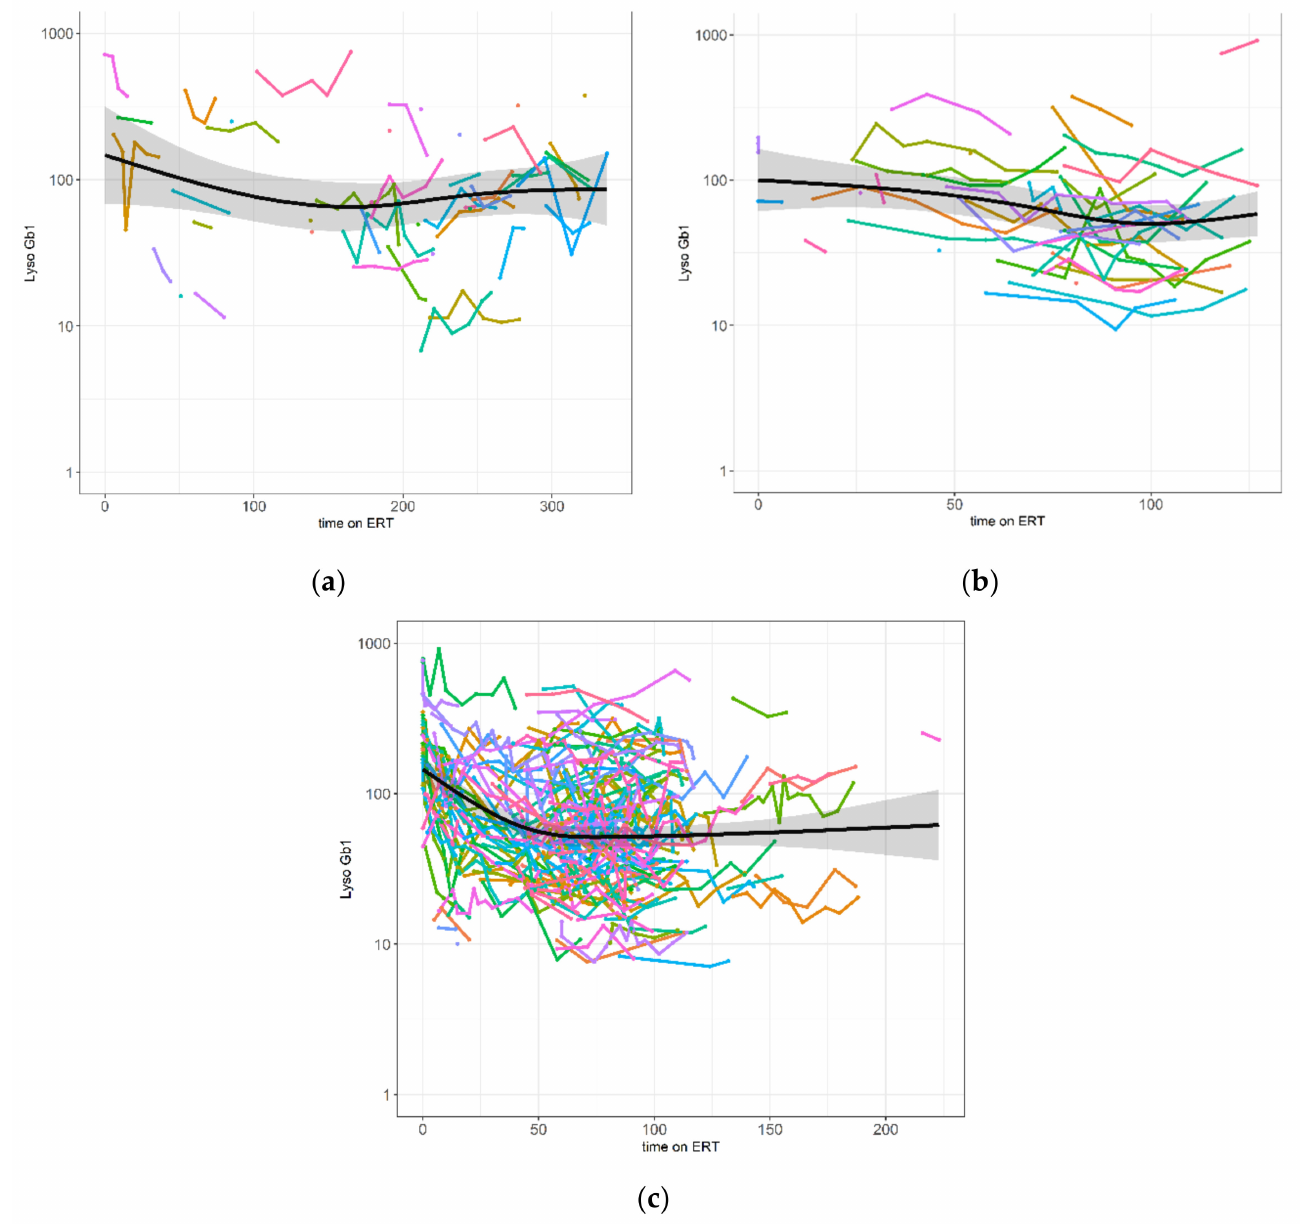
Figure 1. Longitudinal lyso-Gb1 values over time (months) on the three enzyme replacement therapies (ERTs); ( a ) Imiglucerase (41 individuals, 126 measures), ( b ) Taliglucerase alfa (21 individuals, 90 measures), and ( c ) Velaglucerase alfa (73 individuals, 407 measures). Colored lines are aligned to the individual time on ERT at the time of lyso-Gb1 measurement. The black line and grey area indicate the unadjusted regression line (with 95% confidence interval